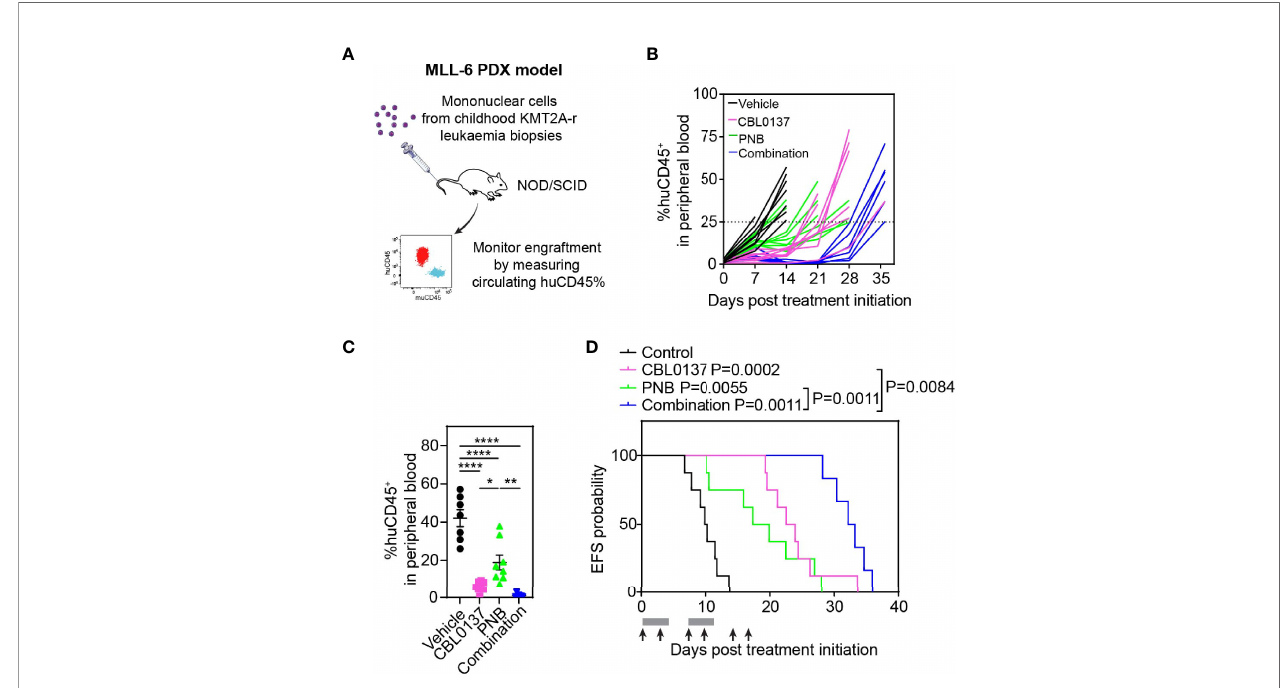
FIGURE 3 | The combination of CBL0137 and panobinostat (PNB) limits infant KMT2A-r ALL PDX progression. (A) Schematic of the infant KMT2A-r ALL PDX model. (B) Leukemia cell levels as measured by enumeration of the % huCD45 + cells in the peripheral blood of individual mice over time. (C) Comparison of % huCD45 + cells in blood of treated mice on day 14 post treatment initiation. Each dot corresponds to one mouse. Statistical signi fi cance of differences in mean engraftment between groups was determined by ANOVA followed by Tukey ’ s multiple comparison test. (D) Kaplan-Meier survival plot with endpoint de fi ned as % huCD45 + cells in the peripheral blood reaching 25% or higher. The solid bar below the survival graphs represents treatment duration for PNB and arrows indicate CBL0137 administration. The Gehan-Wilcoxon test was used to compare survival between treatment groups. P-values comparing survival of control and treatment groups are denoted directly next to the legend. Asterisks represent signi fi cance levels of P values: *P < 0.05, **P < 0.01; ****P <